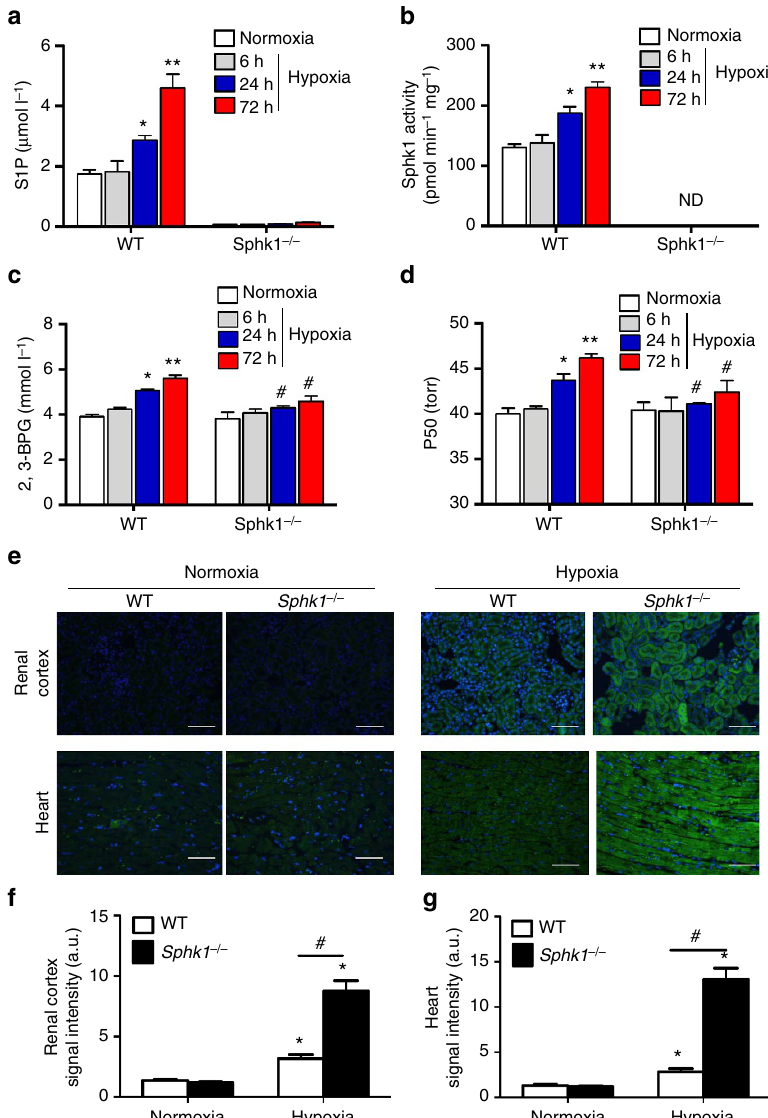
Figure 2 | Hypoxia-induced Sphk1 and S1P increase regulate 2,3-BPG level, O 2 delivery ability and tissue hypoxia in mice. Erythrocyte Sphk1 activity ( a ), S1P level ( b ), 2,3-BPG level ( c ) and P50 ( d ) in WTand Sphk1 (cid:2) / (cid:2) mice in normoxia and hypoxia for different treatment time. ( e ) Tissue hypoxia signals measured by Hypoxyprobe in renal cortex and heart in WT and Sphk1 (cid:2) / (cid:2) mice in normoxia and hypoxia for 72h. Quantification of hypoxia signals in renal cortex ( f ) and heart ( g ). Mean ± s.e.m; n ¼ 6–8 per treatment time point; * P o 0.05 versus 6h or normoxia, ** P o 0.05 versus 24h, # P o 0.05 versus WT, Student’s t -test and one-way ANOVA. Scale bar, 50 m that of ‘ Sphk1 (cid:2) / (cid:2) -to- WT ’ mice after 72-h exposure to hypoxia (Fig. 3f). Further image quantification analysis demonstrated that the intensity of Hypoxyprobe signals in the kidneys and hearts was significantly reduced in the ‘ WT -to- Sphk1 (cid:2) / (cid:2) ’ group